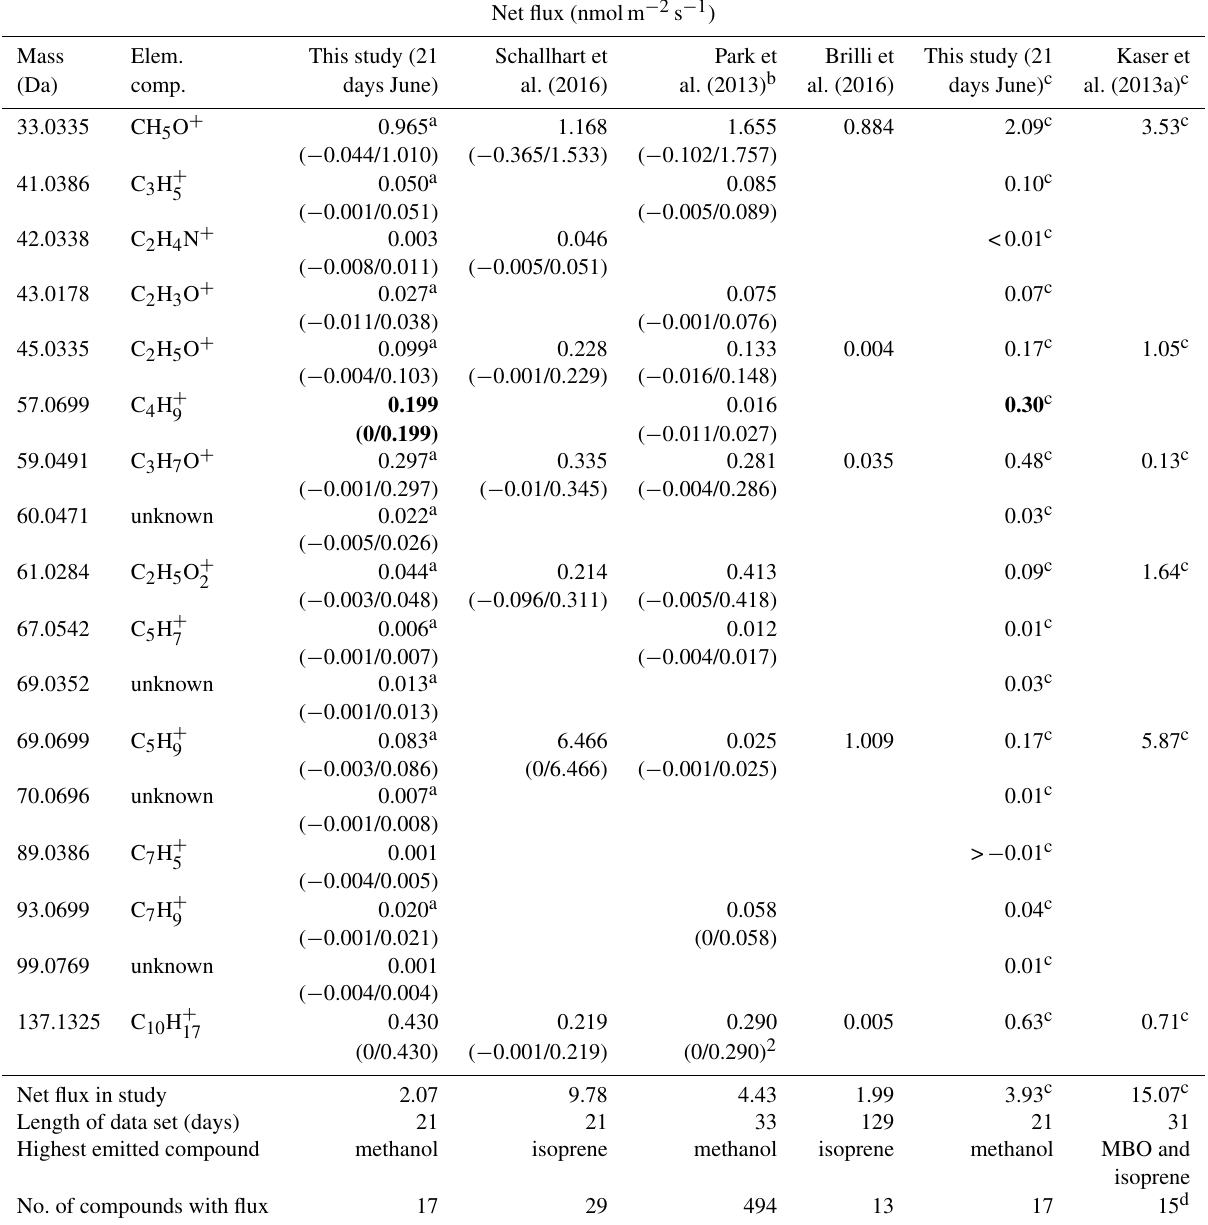
Table 2. Comparison between different studies using a PTR-TOF with the EC method. The listed compounds are limited to the ones measured in Hyytiälä. Numbers in parentheses describe deposition and emission, respectively. All values are 24h averages, except values marked with c . Emissions of butene + butanol are in bold as they are anthropogenic (Sect. 3.4) and, therefore, not included in the total